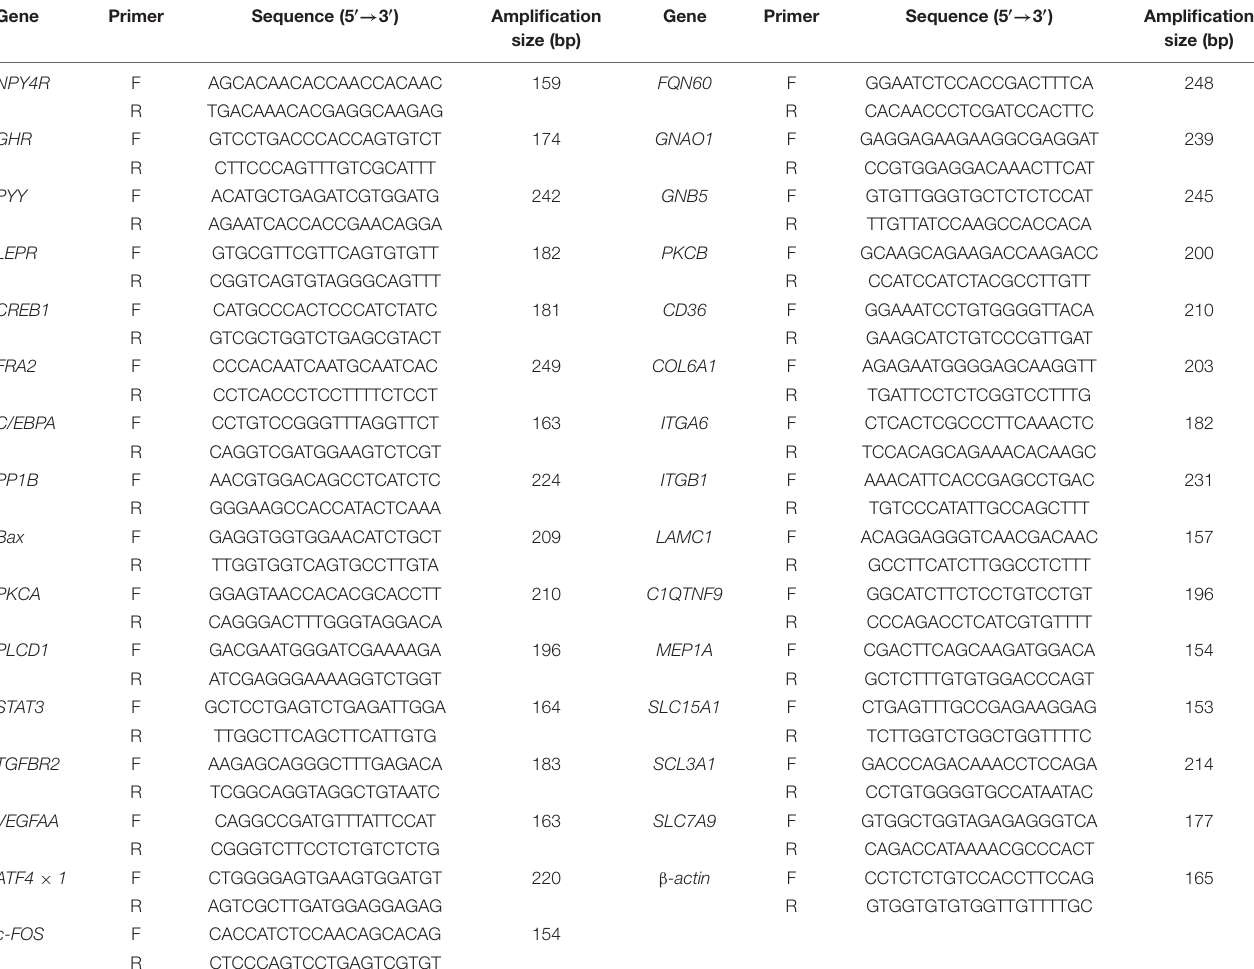
TABLE 1 | Primers and sequences referred in the